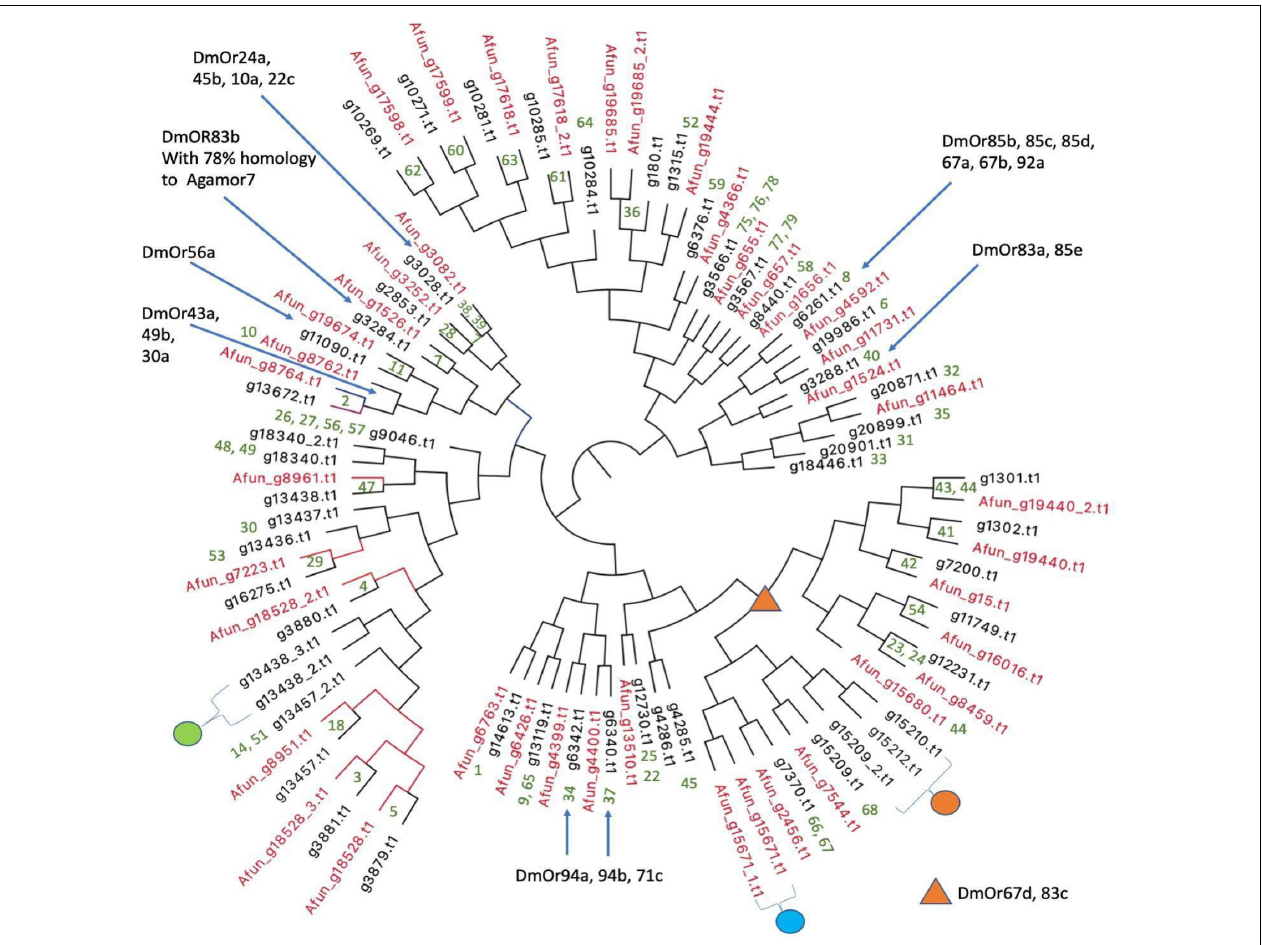
FIGURE 6 | Phylogenetic relationships of olfactory receptors. The 54 ORs of An. stephensi (black) predicted from IndV3s with the 42 ORs predicted for An. funestus (red). Embedded numbers in green are the accession IDs of An. gambiae ORs. The green dot represents ORs missing in An. funestus and expanded into five ORs in An. gambiae including accessions 13, 15, 16, 17, 55. The cyan dot represents ORs missing in An. stephensi , duplicated in tandem in An. funestus and duplicated in An. gambiae with accessions 43–44. The orange dot is missing in An. funestus and expanded into six ORs in An. gambiae with accession IDs of 69–74. The blue arrows and orange triangle show ORs of D. melanogaster based on their orthology to An. gambiae reported elsewhere (Hill et al.,